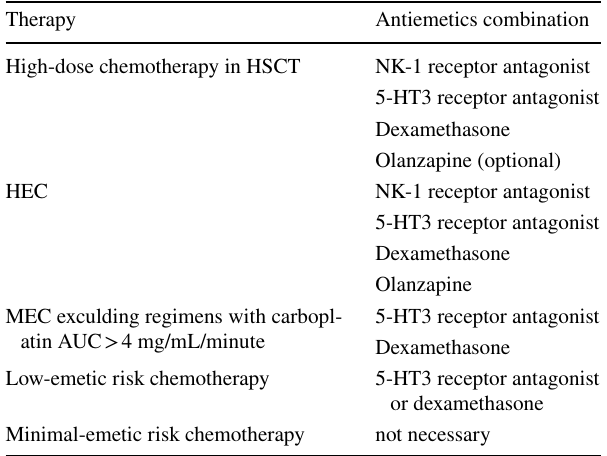
Table 1 Summary of the recommendation on prophylactic antiemet- ics in